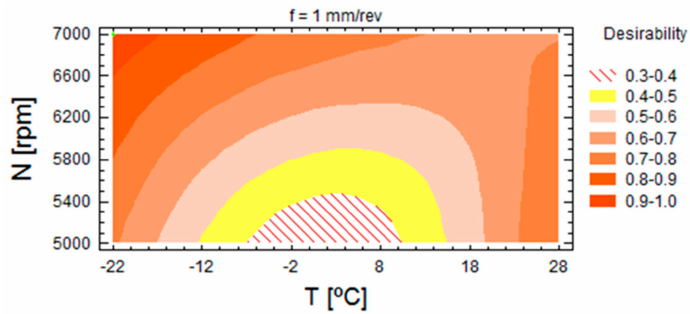
Figure 8. Contours of estimated response surface for f = 1 mm /